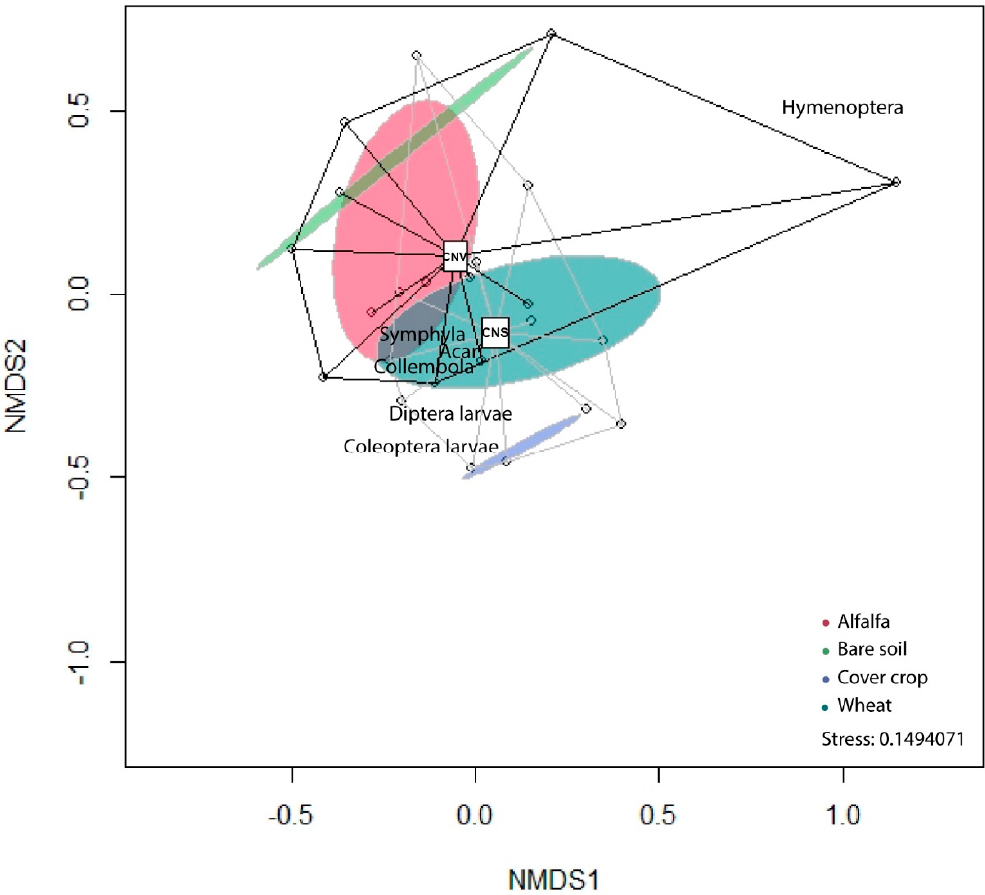
Figure 6. Bray–Curtis based NMDS plot of the arthropod community composition in Gli Ulivi farm. Points represent samples. “Spider” diagrams connect each point to the belonging management type: CNS: conservation, in grey, and CNV: conventional, in black. Ellipses represent crop variables. To avoid overlapping, only the six more abundant groups were labelled.